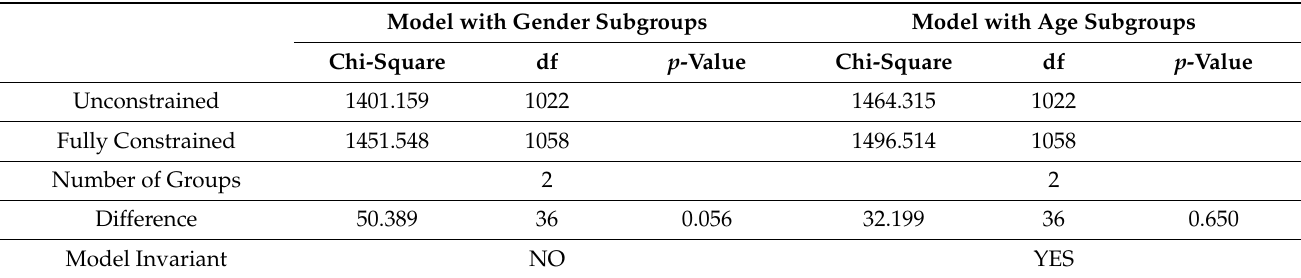
Table 9. Comparison between the models of gender and age subgroups. Model with Gender